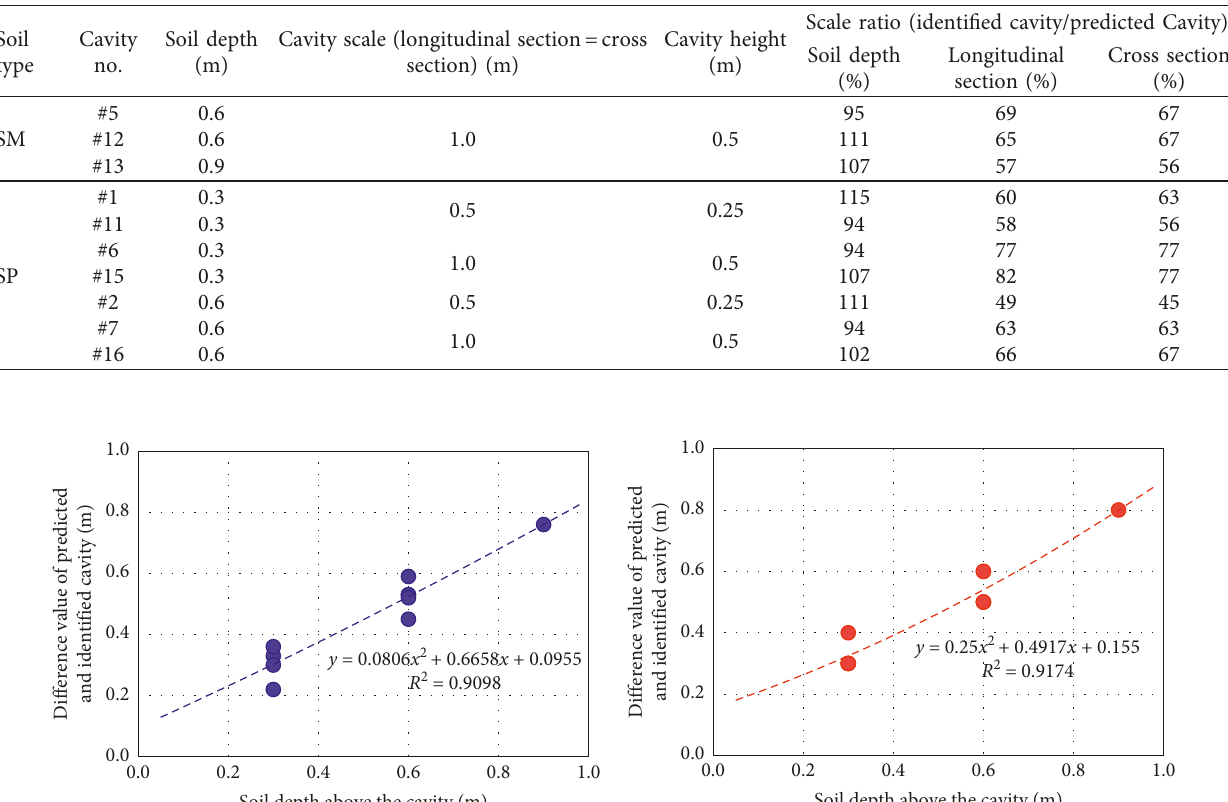
Table 6: Calculation results of the scale ratio.